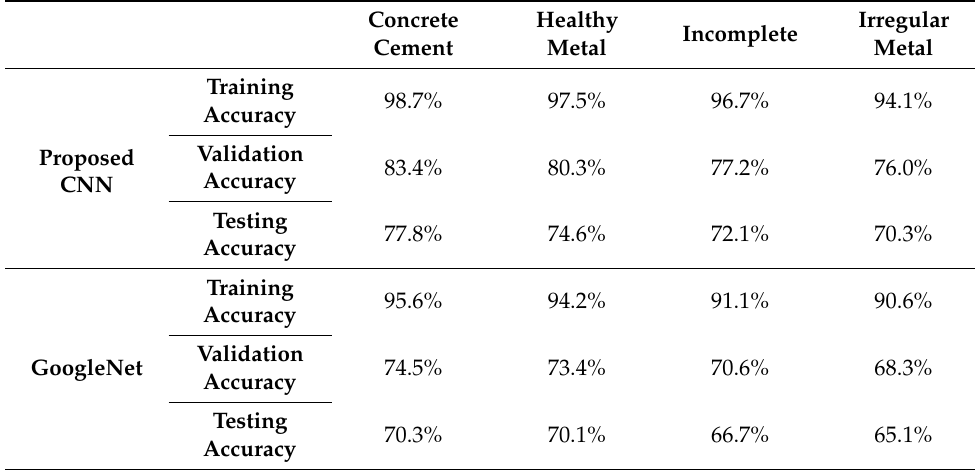
Table 6. Learning Training, Validation, Testing Accuracy result by material.